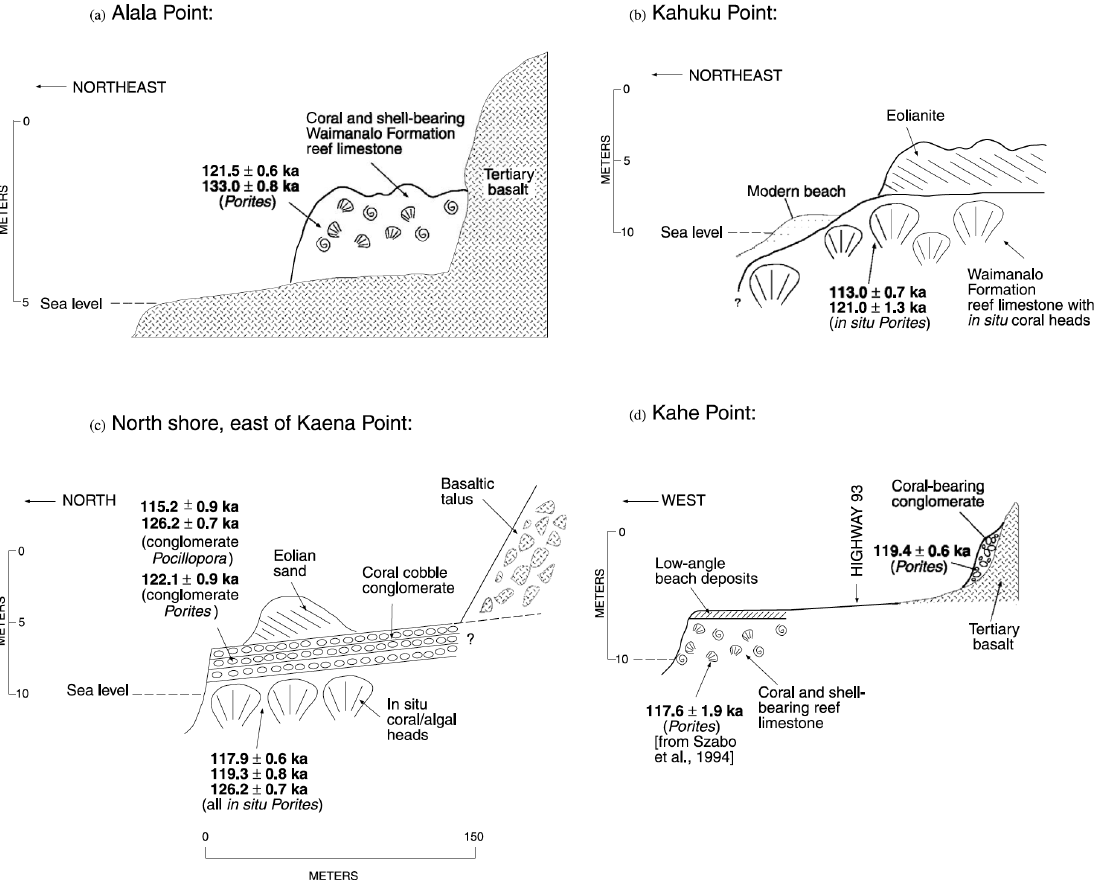
Figure 33. Cross sections of outcrops of the Waimanalo Formation exposed on (a) Alala Point, (b) Kahuku Point, (c) the north shore of Oahu east of Kaena Point and (d) Kahe Point along with reliable U-series ages of corals (from Muhs et al., 2002).